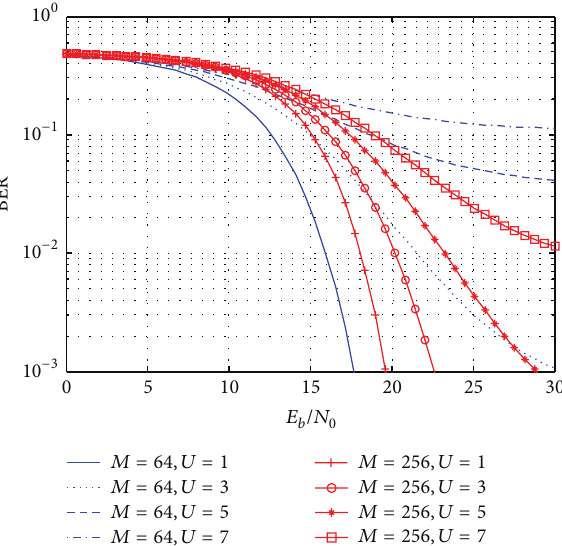
Figure 4: BER performance versus 𝐸 𝑏 /𝑁 0 for different spreading factor 𝑀 .